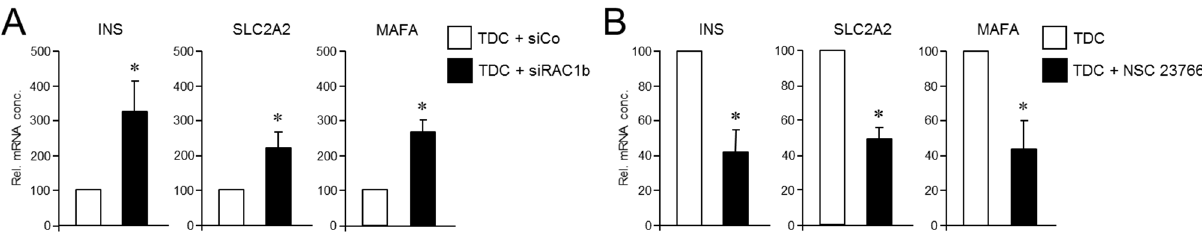
Figure 6. Reciprocal rescue experiments in PANC-1 RAC1-N17 and PANC-1 RAC1b-KO cells and their effect on the TDC-induced β cell transcriptional phenotype. ( A ) PANC-1 RAC1-N17 cells were transfected with 50 nM of either control (siCo) or RAC1b (siRAC1b) siRNA, subjected to FT-based TDC, and subsequently monitored for transcriptional activity of the INSULIN, GLUT2, and MaFA genes by qPCR. ( B ) As in (A), except that PANC-1 RAC1b-KO cells rather than being transfected were treated, or not, during TDC with 50 µM of the RAC1 inhibitor NSC 23766. Data in ( A ) and ( B ) are the mean ± SD ( n = 3). The asterisks ( ∗ ) denote significant differences relative to TDC + siCo or TDC controls ( p < 0.05, Wilcoxon test).